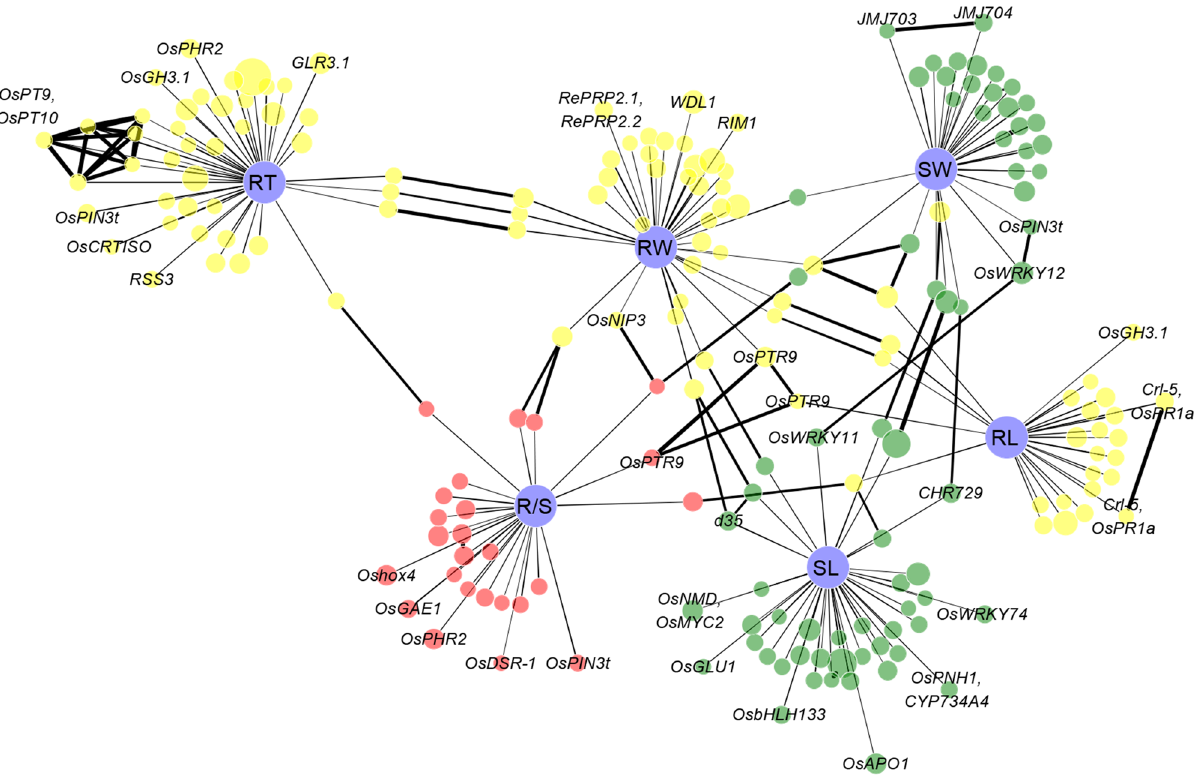
Figure 5. Genome-wide association network for six rice biomass traits. Six traits were represented by violet nodes, and association signals for three root traits (root weight (RW), root length (RL) and root thickness (RT)), two shoot traits (shoot weight (SW) and shoot length (SL)) and ratio of root-to-shoot mass (R/S) were presented by yellow, green and red nodes, respectively. The size of nodes showed the − log( p ) value of corresponding association signals (Table 1). Link between trait and association signal indicated their association. The links between association signals for different biomass traits indicated strong LD with R 2 > 0.2, and the thickness of link showed LD value (Table